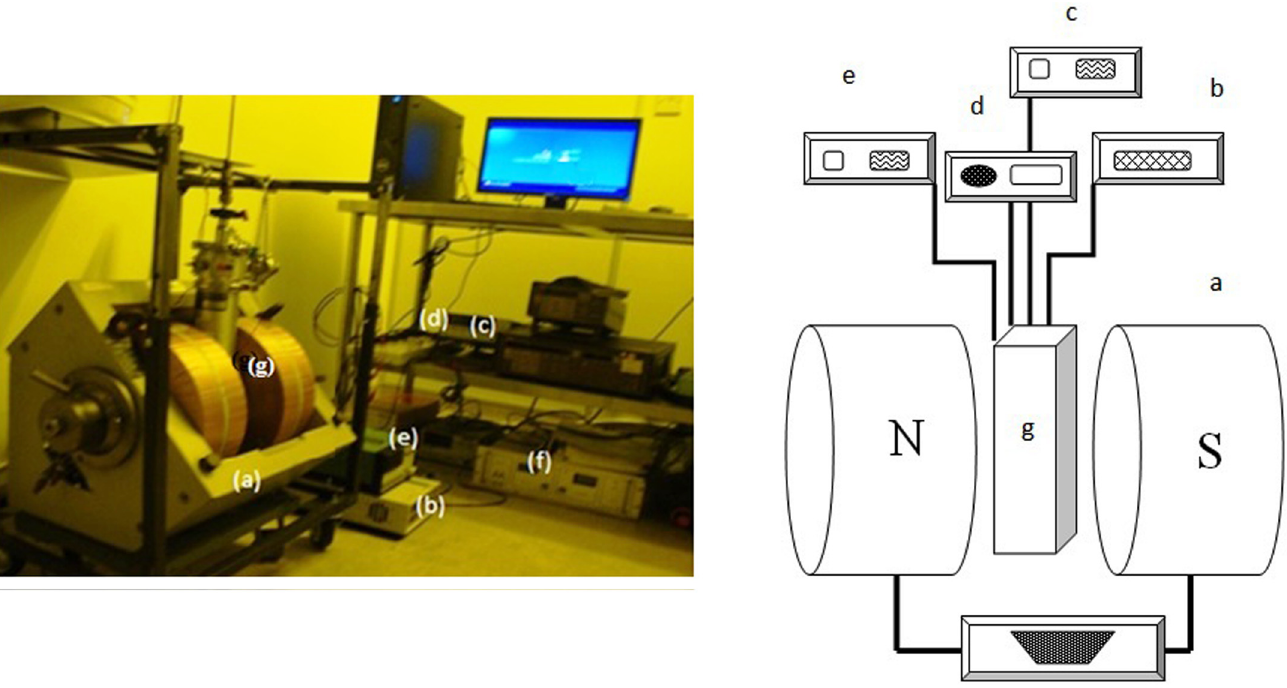
Fig 5. DNA is placed inside the magnetic field. Prepared oligonucleotide DNA sample is placed inside the magnetic field. Components include (a) electromagnet, (b) thermometer, (c) multimeter, (d) timer, (e) Gauss meter, (f) electromagnet power supply and (g) DNA sample. Sub Fig reflects a schematic aspect of prepared set